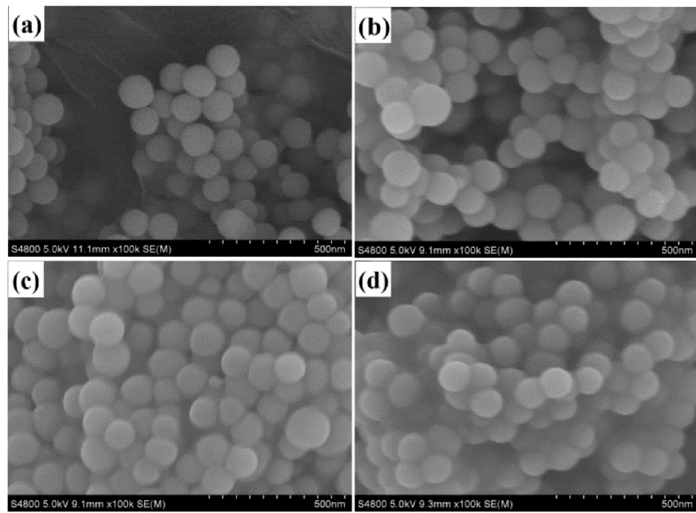
Figure 8. SEM images of nano-SiO 2 ( a ). SiO 2 , ( b ). KH550-SiO 2 , ( c ). KH560-SiO 2 , ( d ). KH570-SiO 2 .